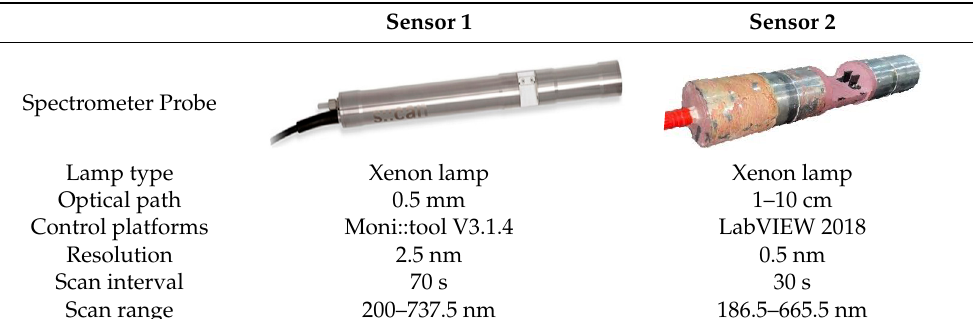
Table 1. Comparison of the parameters of the two sensors.